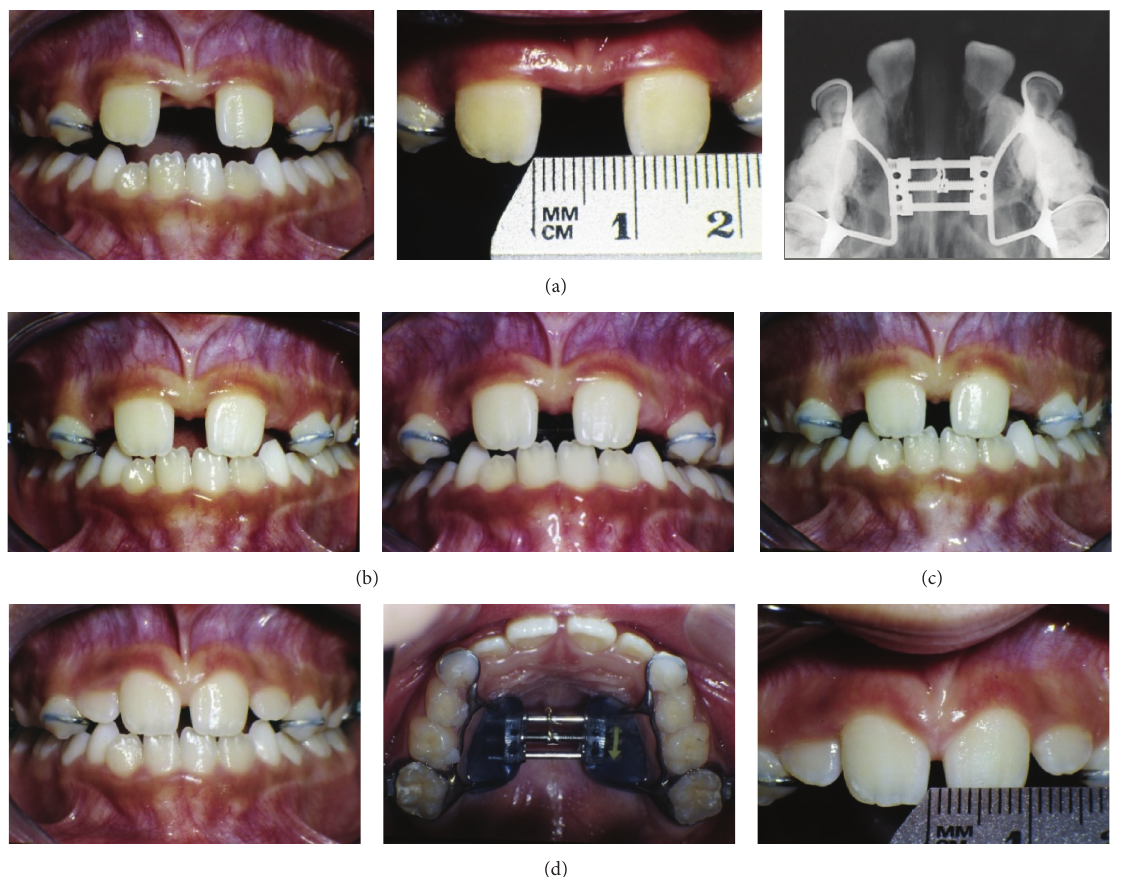
Figure 2: Midline diastema with clinical signs of the suture opening. Occlusal radiographs with real disjunction of the suture. (a) After three weeks and 52 screw activations. (b) 43 days and (c) and (d) 5 months and 6 months after retention. The diastema returned to the initial dimensions in the retention phase of the